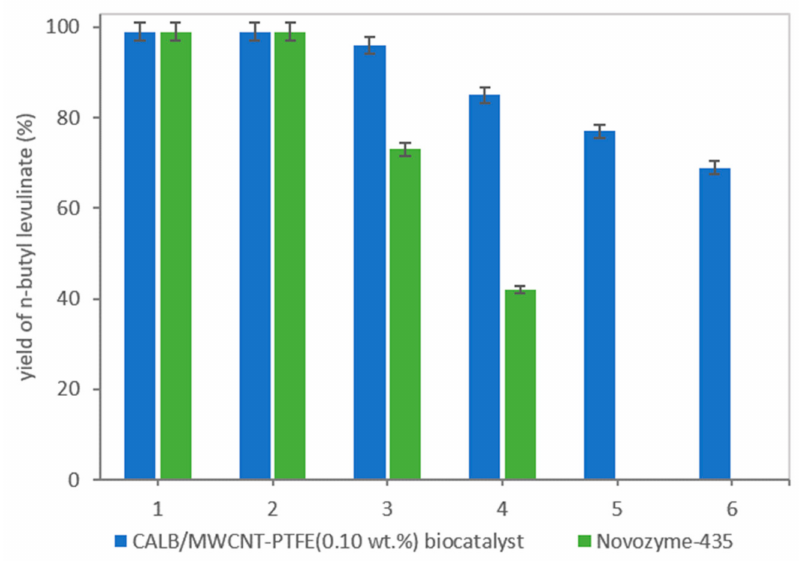
Figure 9. Catalyst recycling. Reaction conditions: LA (0.117 g, 1 mmol); n -butanol (0.148 g, 2 mmol); biocatalyst CALB/MWCNT-PTFE (0.10 wt.%) (150 mg); cyclohexane (1 mL); 45 min, 20 ◦ C; 250